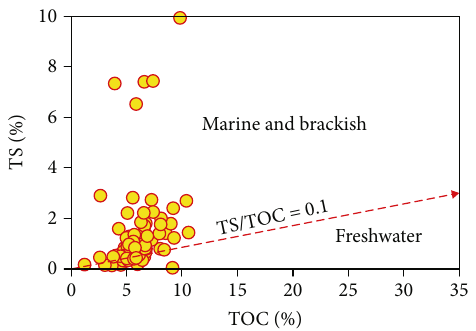
Figure 12: Discrimination diagram of total sulfur (TS) versus total organic carbon (TOC) [64] for the paleosalinity of Chang 7 3